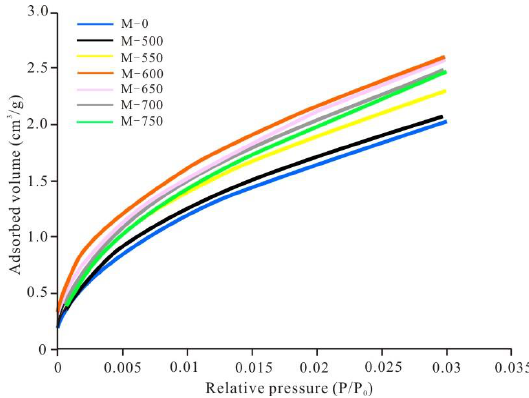
Figure 1. Low–pressure CO 2 adsorption isotherms of the shale samples at different temperatures.